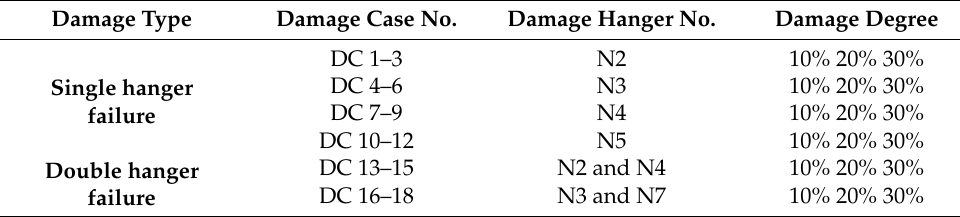
Table 1. Eighteen damage conditions simulated by FEM .